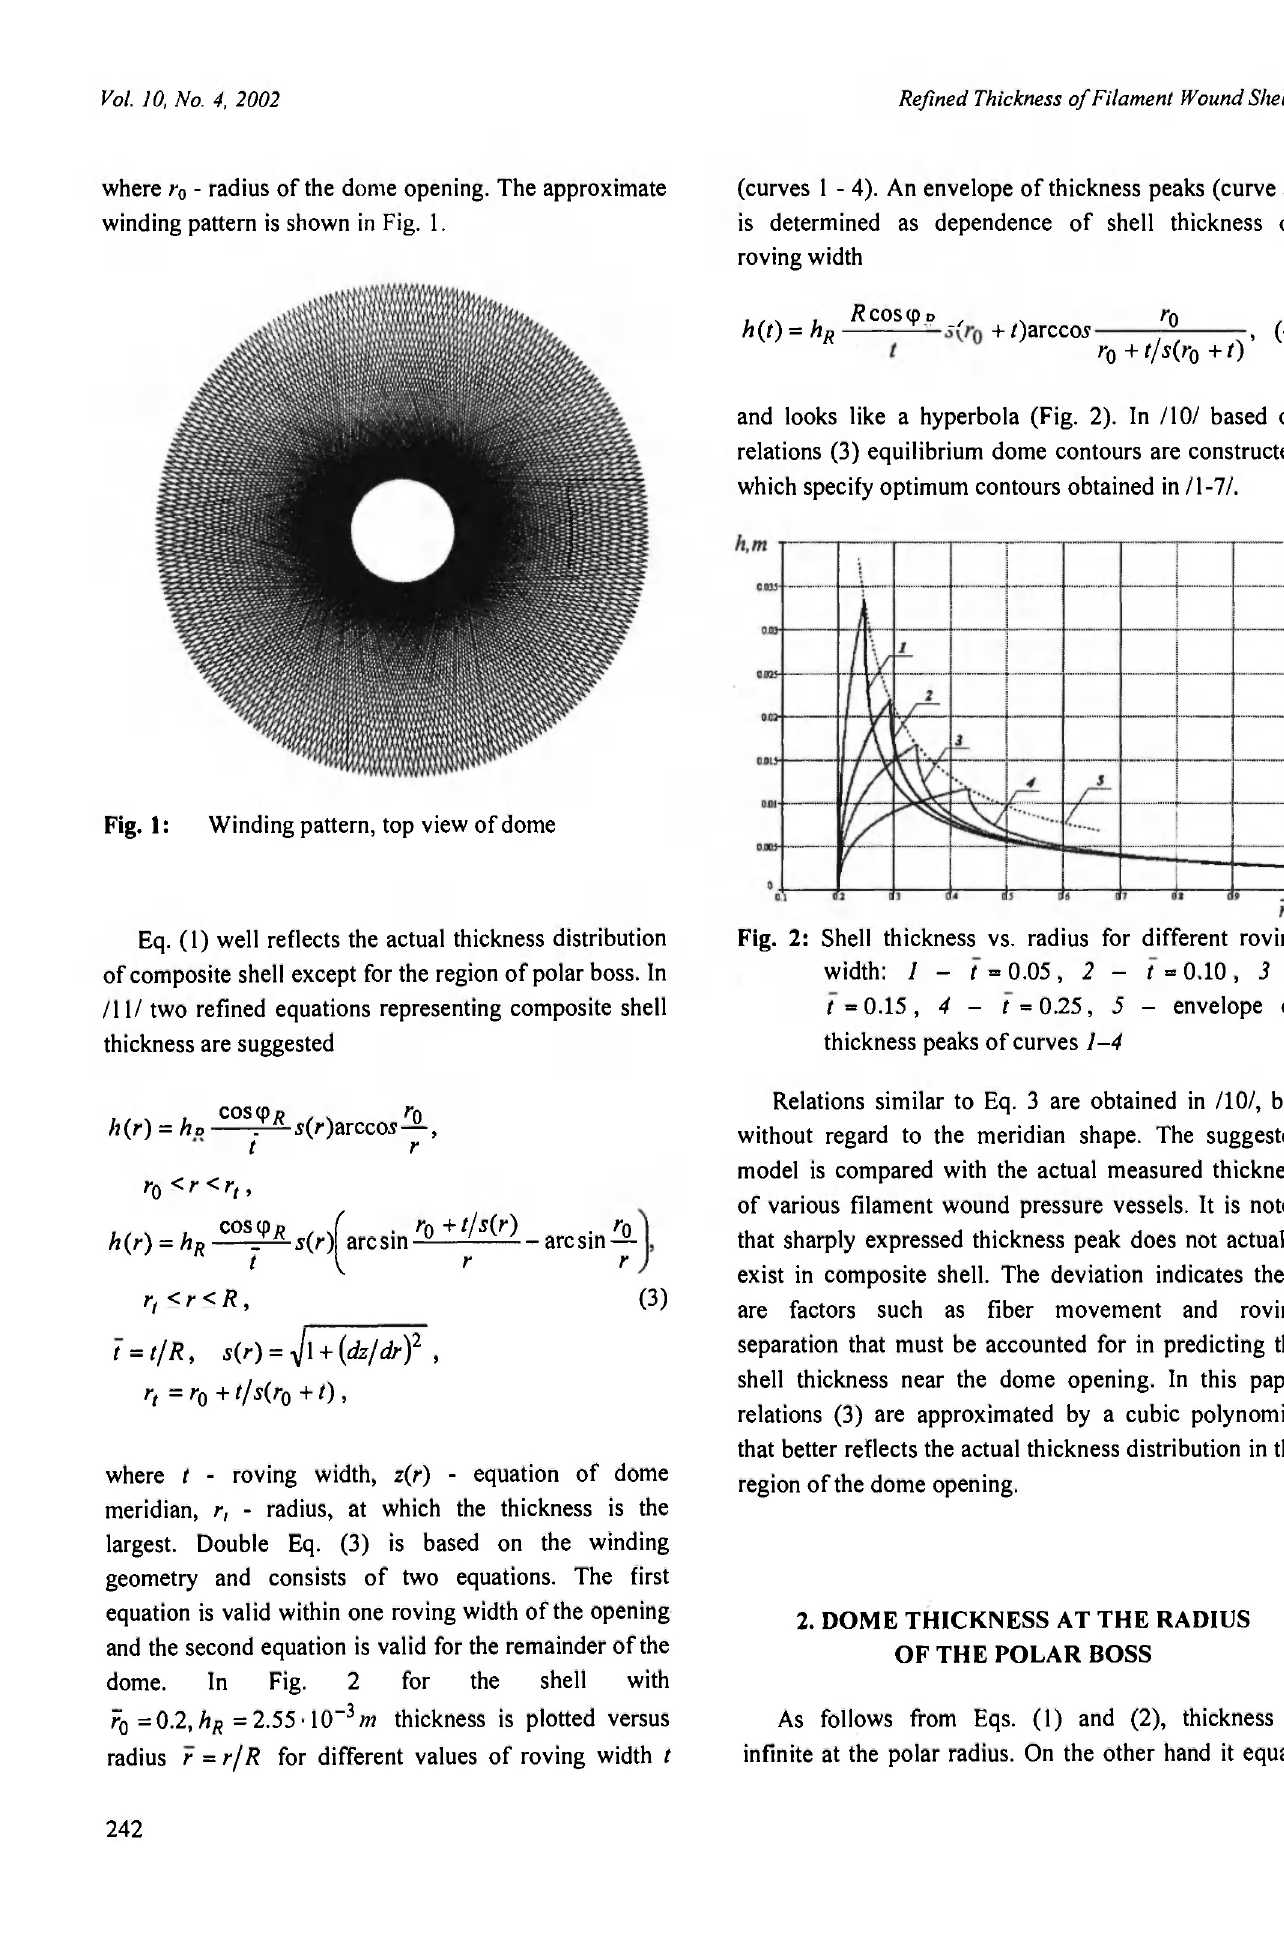
Fig. 2: Shell thickness vs. radius for different roving width: 1 - t = 0.05, 2 - - t = 0.15 , 4 - t = 0.25, 5 - envelope of thickness peaks of curves